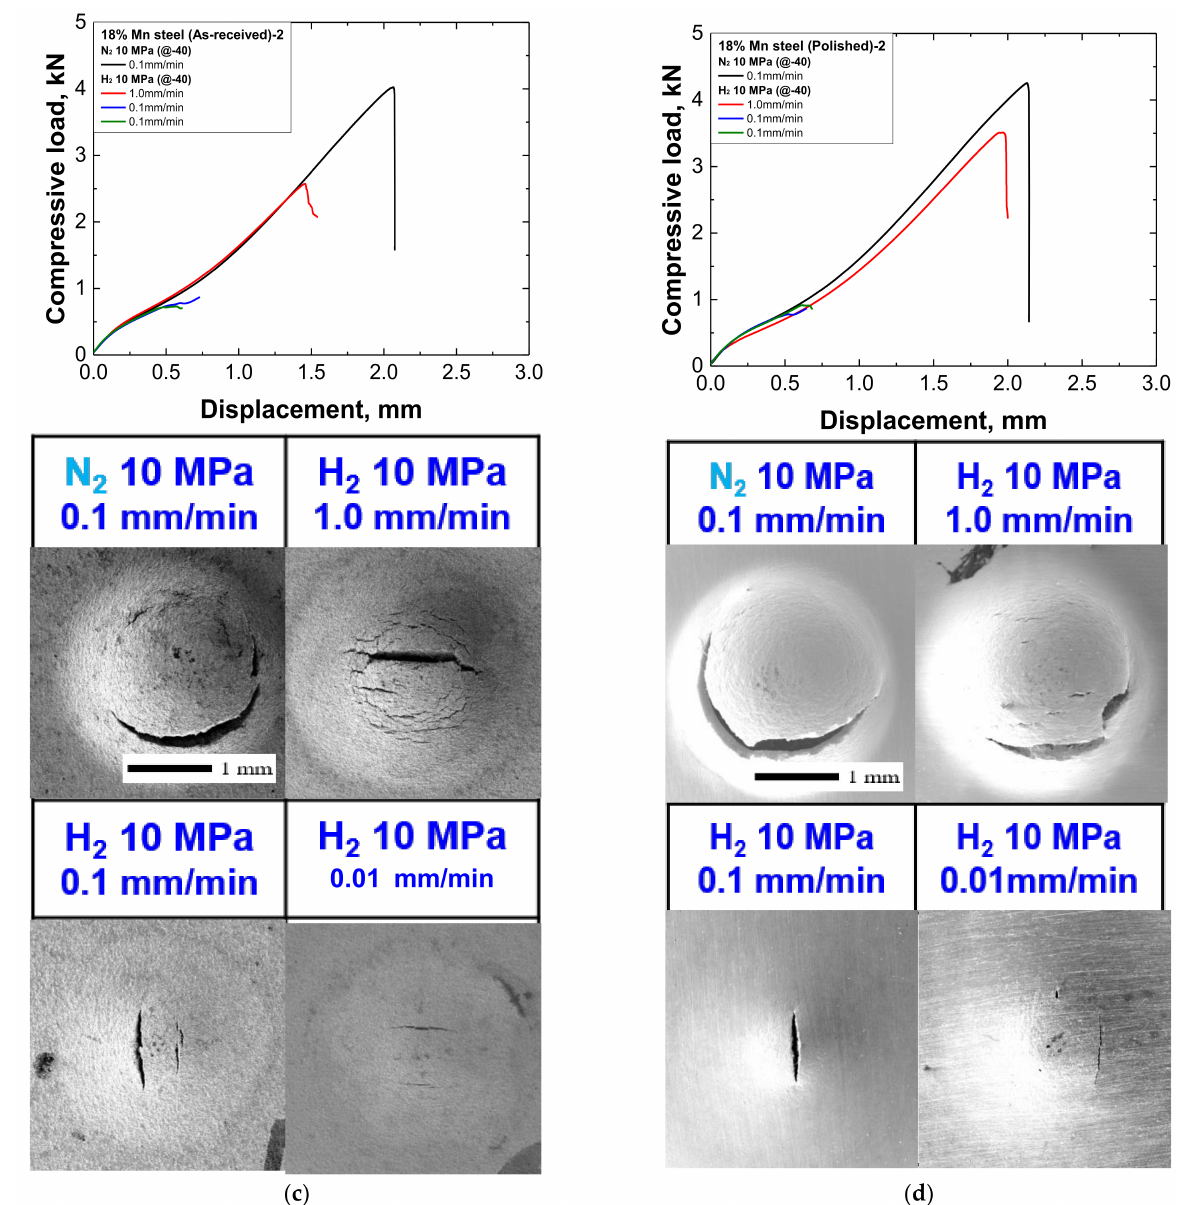
Figure 4. Load-displacement curves and fracture morphologies obtained for 18% Mn steel specimens of two surface finishes, tested under various conditions. ( a ) Wirecut at RT; ( b ) Polished at RT; ( c ) Wirecut at − 40 ◦ C; ( d ) Polished at − 40 ◦